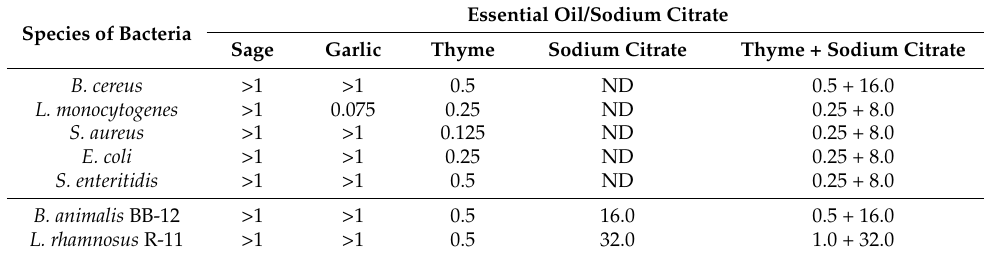
Table 1. Minimum inhibitory concentrations (MIC) of essential oils and sodium citrate against food pathogens, contaminant bacteria and probiotic bacteria. Results are expressed in concentration of mg mL − 1